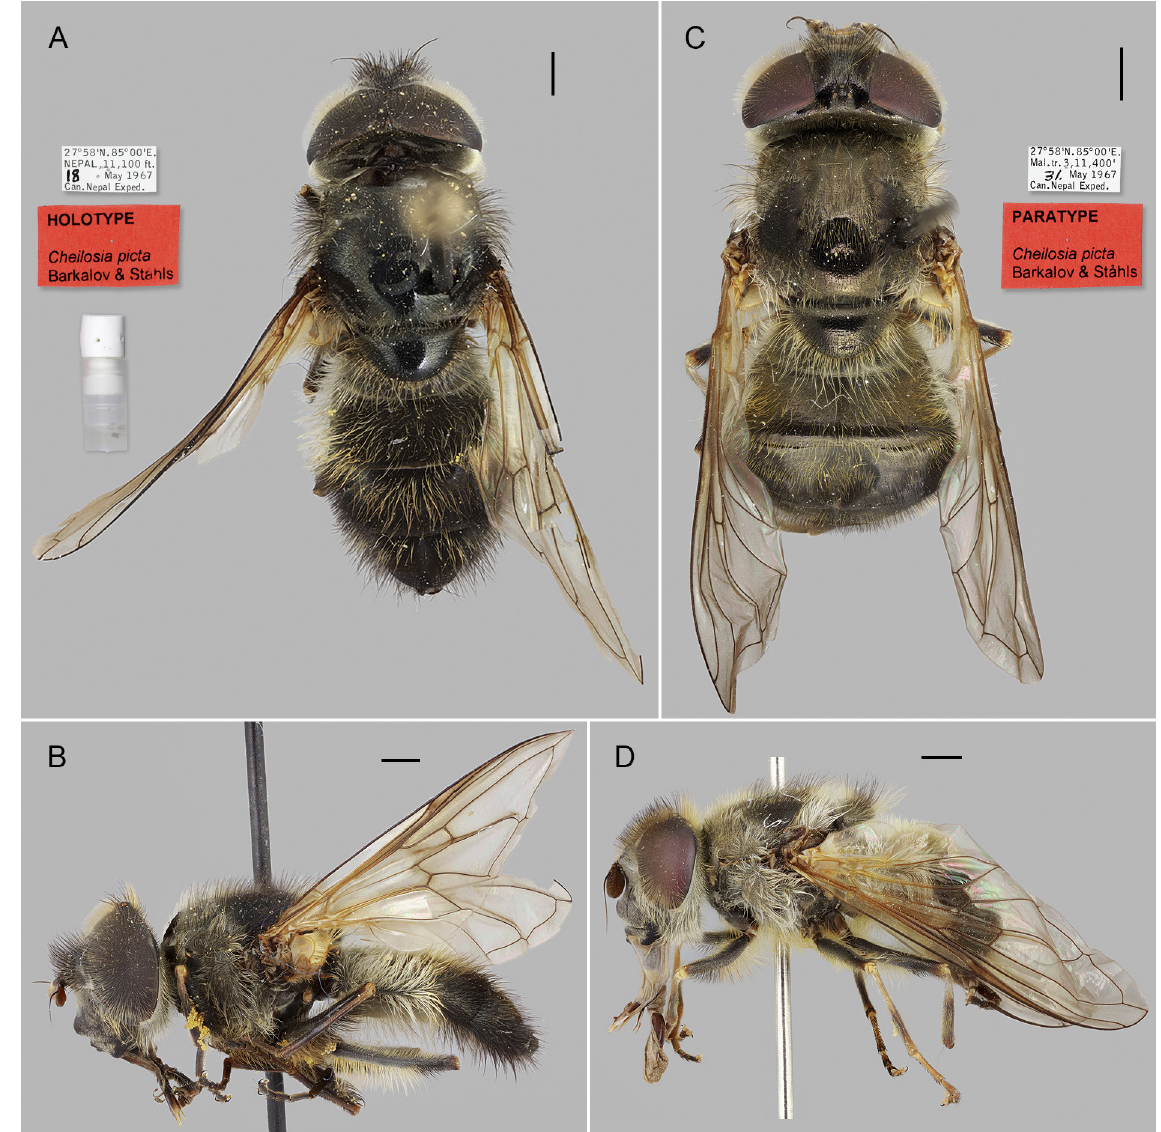
Fig. 51. Cheilosia ( Montanocheila ) picta sp. nov. A–B . Holotype, ♂ (CNC), dorsal and lateral views. C–D . Paratype, ♀ (CNC), dorsal and lateral views. Photo: Pekka Malinen, FMNH Luomus. Scale bars = 1